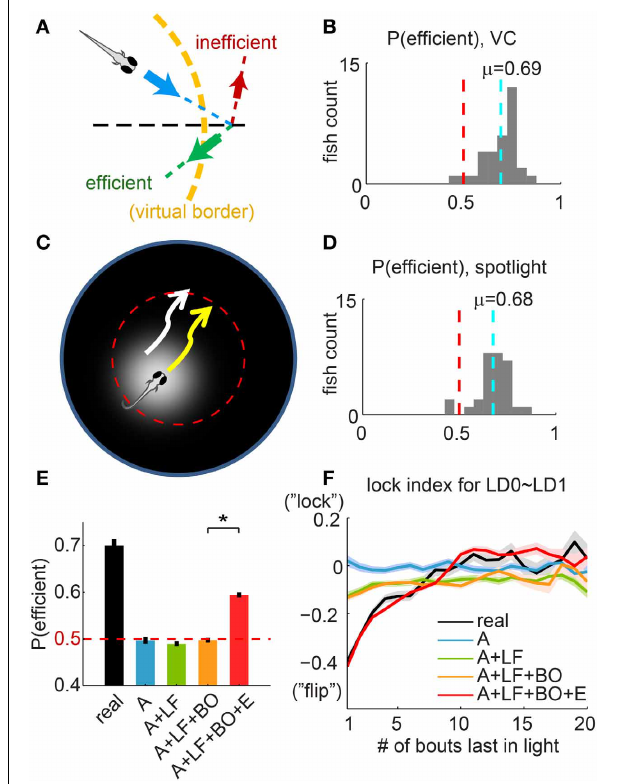
FIGURE 5 | Choice of efficient turning direction suggests sophisticated navigation ability. (A) Illustration of “efficient” vs. “inefficient” turns. For a fish approaching the virtual border (dashed yellow line) along the direction indicated by the blue arrow, in order to return to the light, a turn in one direction (green arrow) is more “efficient” than in the other direction (red arrow). Dashed black line: radial direction. (B) Histogram of the per-fish “efficiency,” summarized for all fish in the VC assay. The 50/50 probability (pure chance) is indicated with a dashed red line. The dashed cyan line marks the mean of the distribution (0.69 ± 0.016, mean ± s.e.m, n = 32). (C) “Spotlighted” Virtual Circle experiment, to control for potential asymmetries in the visual field that can be used as visual cues. The projected spotlight is centered at the fish at all times, except when the fish exits the virtual border (dashed red line) and the light is turned off. (D) Histogram of the per-fish “efficiency”, for 30 fish from the “Spotlighted” Virtual Circle experiment. The mean of this population (0.68 ± 0.016, mean ± s.e.m, n = 30) is unchanged compared to (B) . (E) The average “efficiency” compared between real fish and different simulations. Simulations are labeled by all the algorithms implemented: “A” = Algorithm I [Angle], “LF” = Algorithm II [Lock/Flip], “BO” = Algorithm III [Bounce], “E” = Algorithm IV [Efficiency]. Dashed red line indicates the value of pure chance. None of the first 3 simulations (blue, green, and orange) produce an “efficiency” that is statistically different from chance. Only the simulation applying Algorithm IV, as described in (F) , enhances the “efficiency” significantly to 0.59 ± 0.005 (mean ± s.e.m). (F) The lock-index for the last turn in light (LD0) and first turn in dark (LD1), plotted as a function of the length of the immediately preceding interval in light. Note that for the previous simulations, the lock-index does not change significantly with the length of the preceding light interval. For the simulation with Algorithm IV [Efficiency], the turning direction of the first turn in dark (LD1) is constrained so that this lock-index curve (in red) mimics the curve from real fish (in black). ∗ p < 0 .